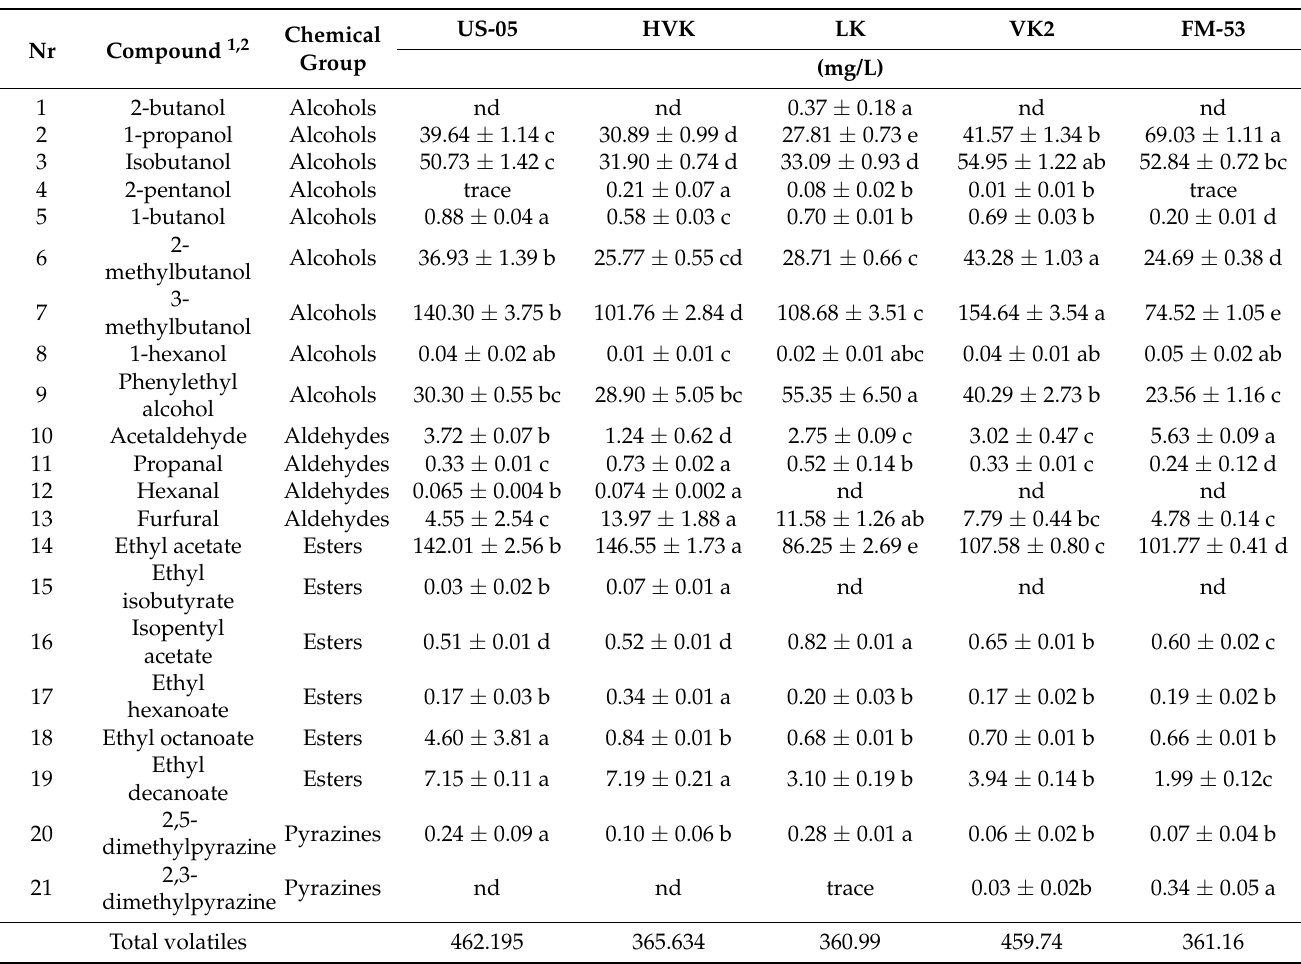
Table 4. Concentration of volatile compounds in beers produced with the use of KVEIK